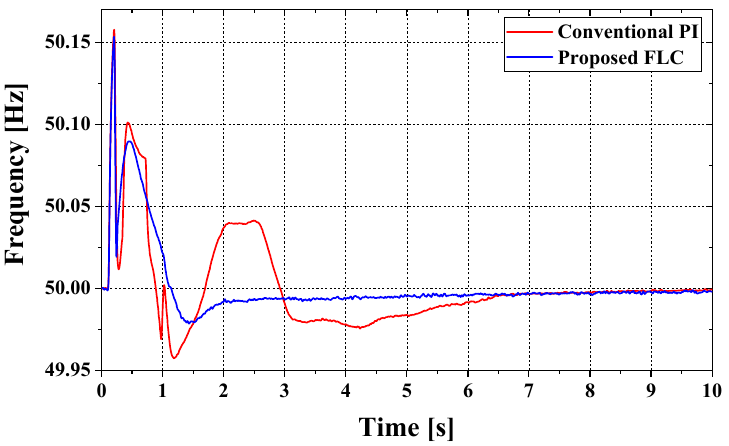
Figure 15. Frequency profile of the power systems.